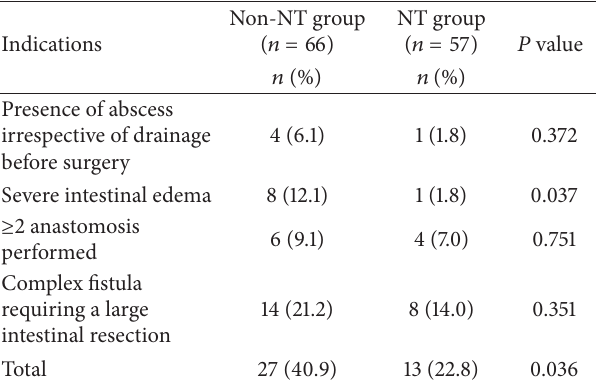
Table 5: Temporary